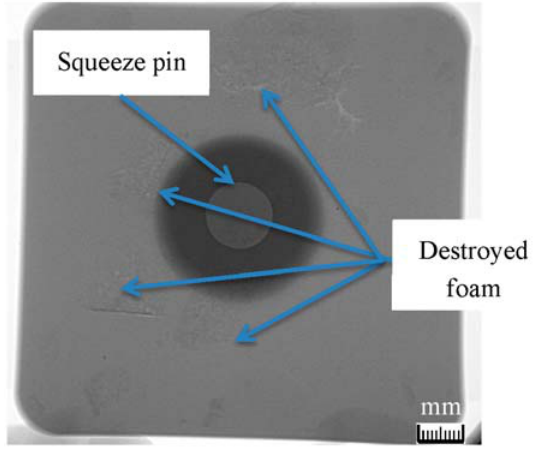
Figure 14. 1.55 Kg/dm 3 Aluminium foam after squeeze pin application.